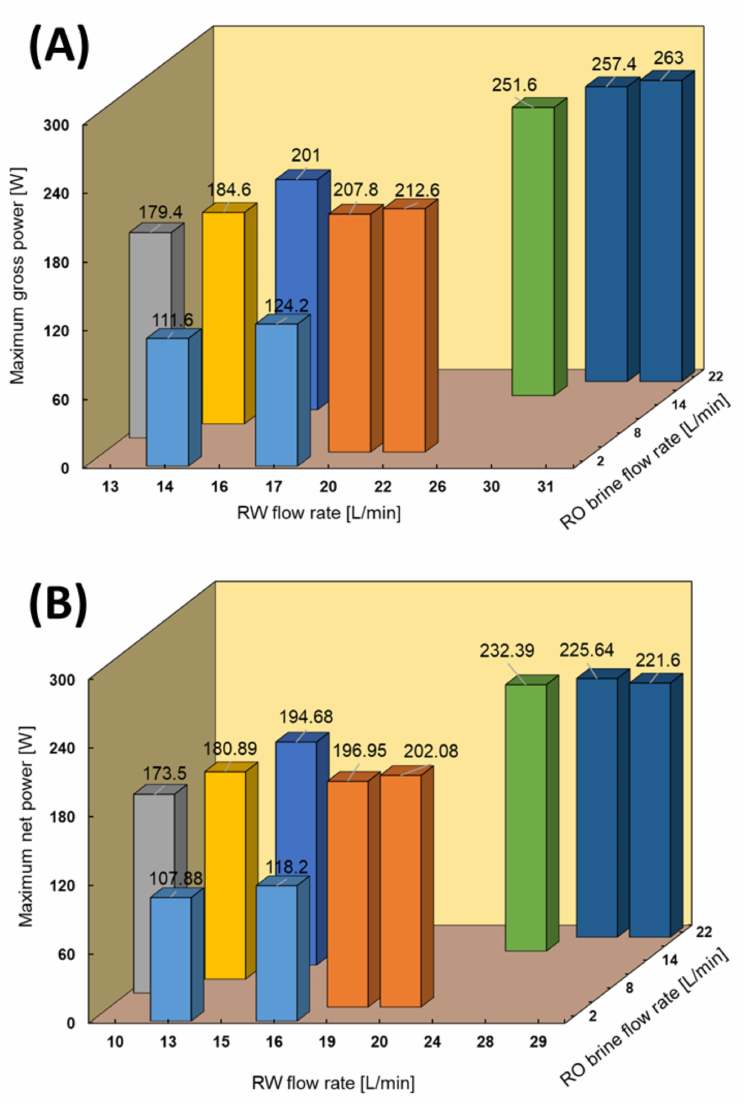
Figure 7. RED stack performance using model RO brine/RW feed solutions. ( A ) Maximum gross power density against feed flow rate, ( B ) Maximum net power against feed flow